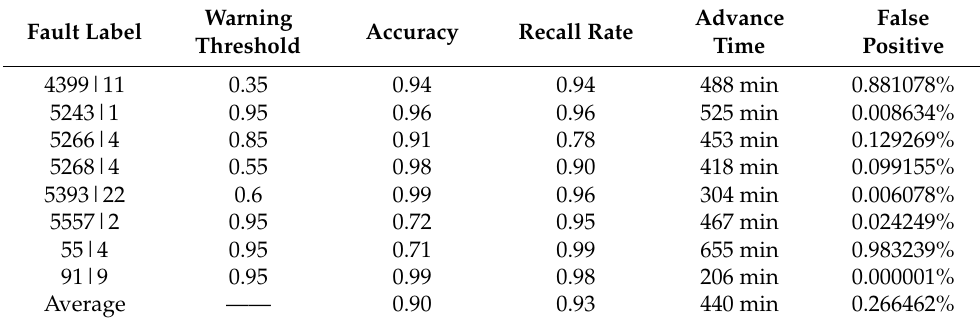
Table 5. Early warning performance of various faults. Fault